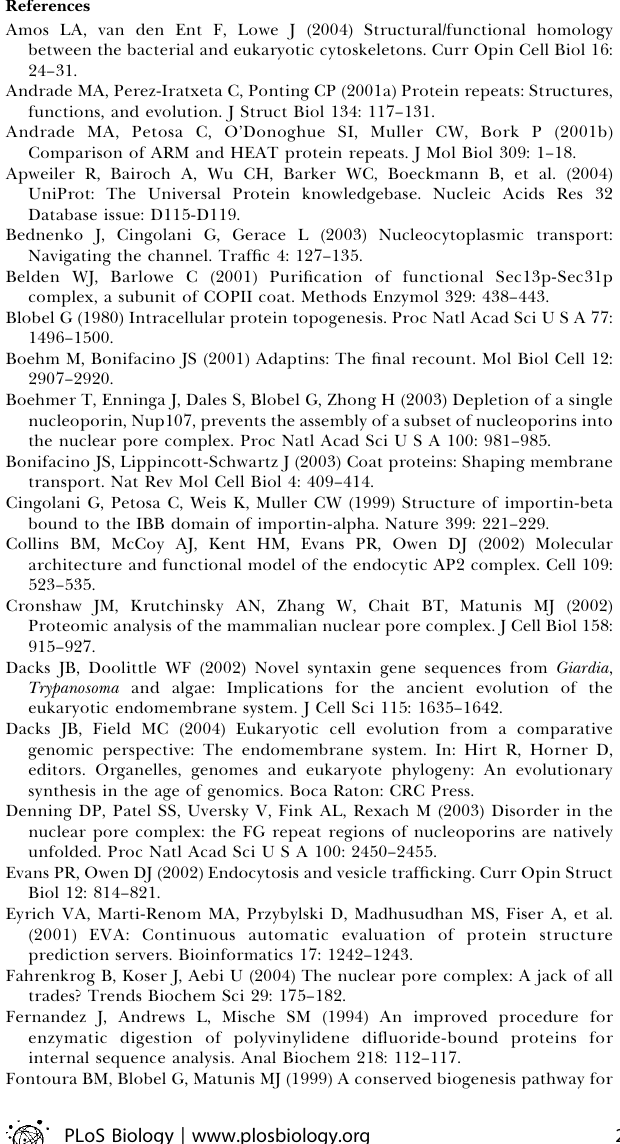
Table S2. Modeling Results for Yeast Nup84 Complex Proteins II (yNup133) Found at DOI: 10.1371/journal.pbio.0020380.st002 (101 KB DOC). Table S3. Modeling Results for Yeast Nup84 Complex Proteins III (yNup133) Found at DOI: 10.1371/journal.pbio.0020380.st003 (115 KB DOC). Table S4. Modeling Results for Yeast Nup84 Complex Proteins IV (yNup133) Found at DOI: 10.1371/journal.pbio.0020380.st004 (132 KB DOC). Table S5. Modeling Results for Yeast Nup84 Complex Proteins V (yNup133) Found at DOI: 10.1371/journal.pbio.0020380.st005 (124 KB DOC). Table S6. Modeling Results for Yeast Nup84 Complex Proteins (yNup133) Found at DOI: 10.1371/journal.pbio.0020380.st006 (93 KB DOC). Table S7. Modeling Results for Human and Plant Nup84 Complex Proteins (yNup133) Found at DOI: 10.1371/journal.pbio.0020380.st007 (144 KB